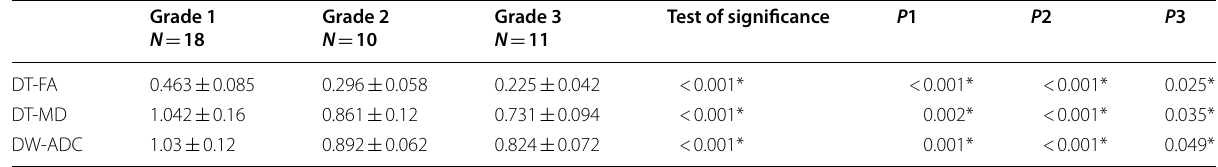
F One Way ANOVA test, P : probability, *statistically significant if P < 0.05 =